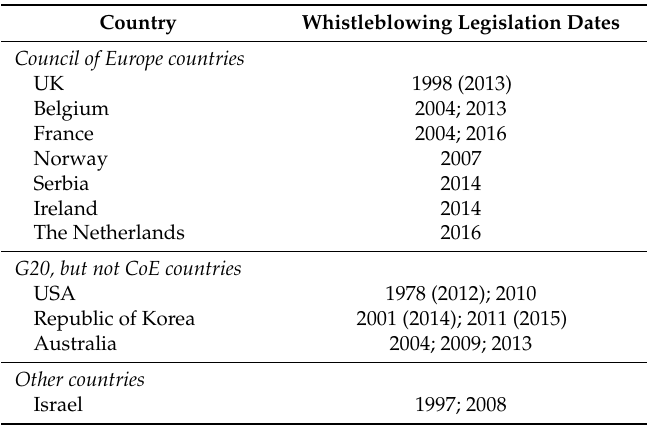
Table 1. Final sample of countries included in this